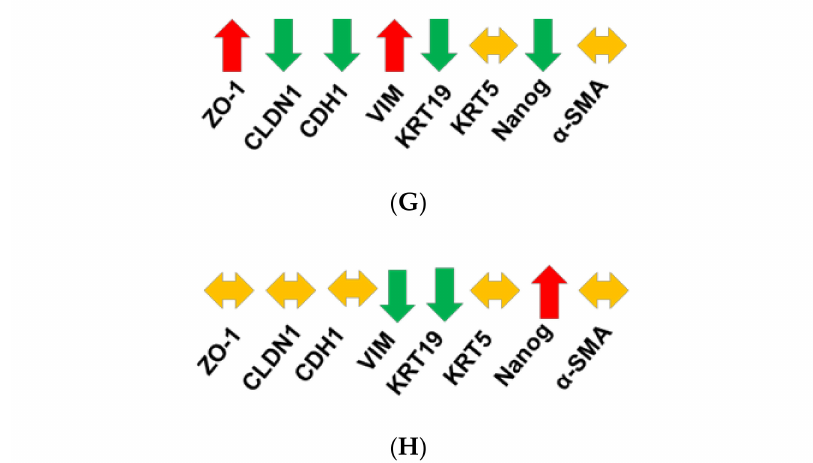
Figure 8. Changes in mRNA expression of early (p-14) and late (p-80) iSGEC-nSS2 cultures grown on matrigel. Legend. mRNA expression of early (p-14) and late (p-80) passaged iSGEC-nSS2 grown on either uncoated (monolayer) or matrigel coated plates by qRT-PCR ( ∆ CT). Changes in gene expression are indicated with arrows: increased ( red ), decreased ( green ), and no change ( yellow ). ( A – C ) AQP5 expression was the only acinar cell marker to increase in both p-14 ( B ) and p-80 ( C ) when cultured on matrigel (final: 2mg / mL) coated plates. In p-80 cells, matrigel had a greater e ff ect on AQP5 expression compared to p-14. ( D ) Over extended passages, iSGEC-nSS2 expressed both AQP5 and AMY1A higher, whereas ANO1 decreased in expression over time. ( E – H ) The mRNAs of characterization markers CLDN1, CDH1, VIM, and KRT19 were di ff erentially expressed in both p-14 and p-80 cultures, respectively, when grown as a monolayer or matrigel coated plates. ( F – G ) Only the ductal cell marker, KRT19, was consistently downregulated by matrigel. ( F – G ) Vimentin (VIM) can be an indicator of dedi ff erentiation in SGECs and was increased ( red ) in both p-14 and p-80 matrigel cultures. Results calculated by Student’s t -test and p -values corrected by the Holm-Š í d á k multiple comparisons test (* p < 0.05). Error bars represent mean +/ −